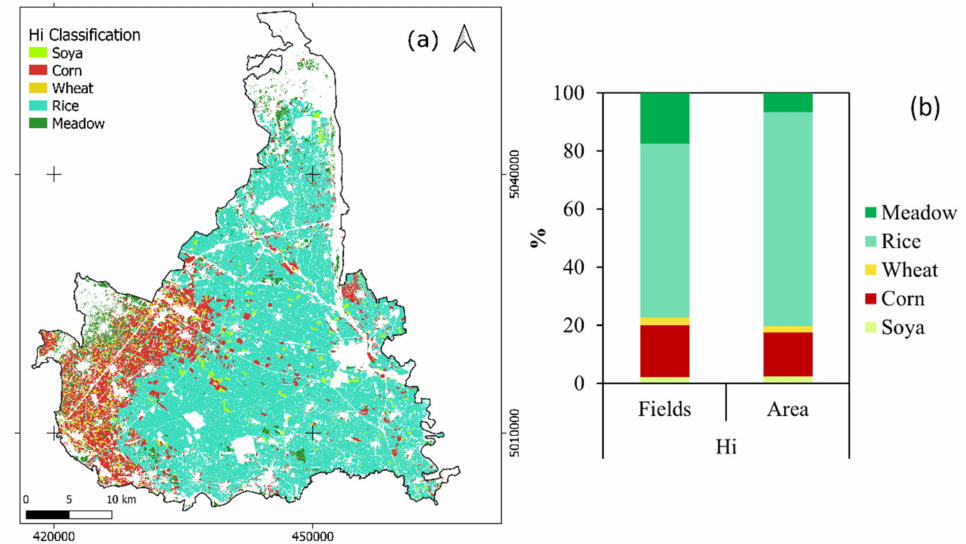
Figure 11. ( a ) Rule-based hierarchical classification map. ( b ) Fields (%) and surface (%) monitored for each crop in HI classification (reference system is WGS84/UTM 32N, EPSG: